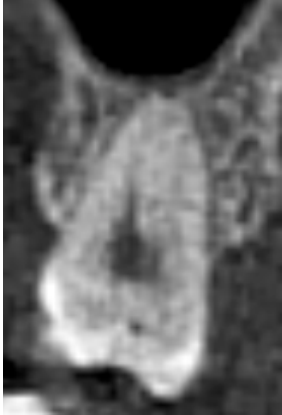
Figure 1. H—the healthy teeth.